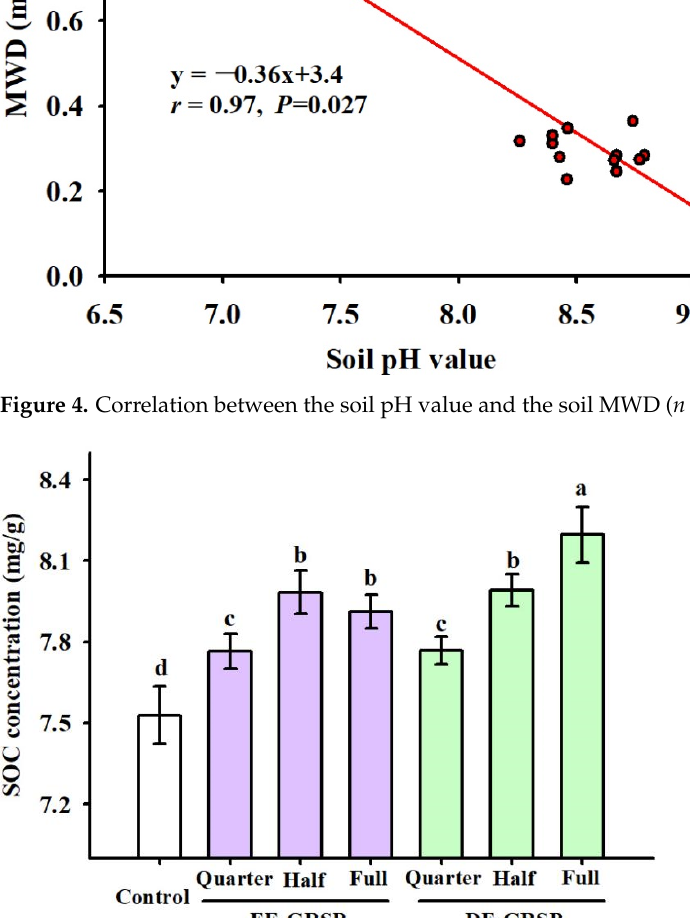
Figure 4. Correlation between the soil pH value and the soil MWD ( n = 28).